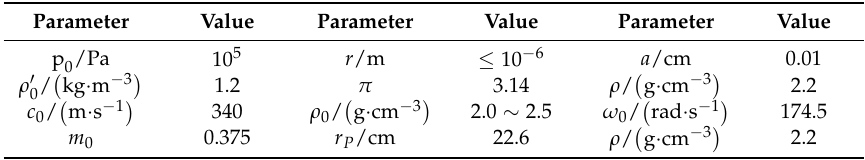
Table 1. Key parameters required for the numerical analysis.